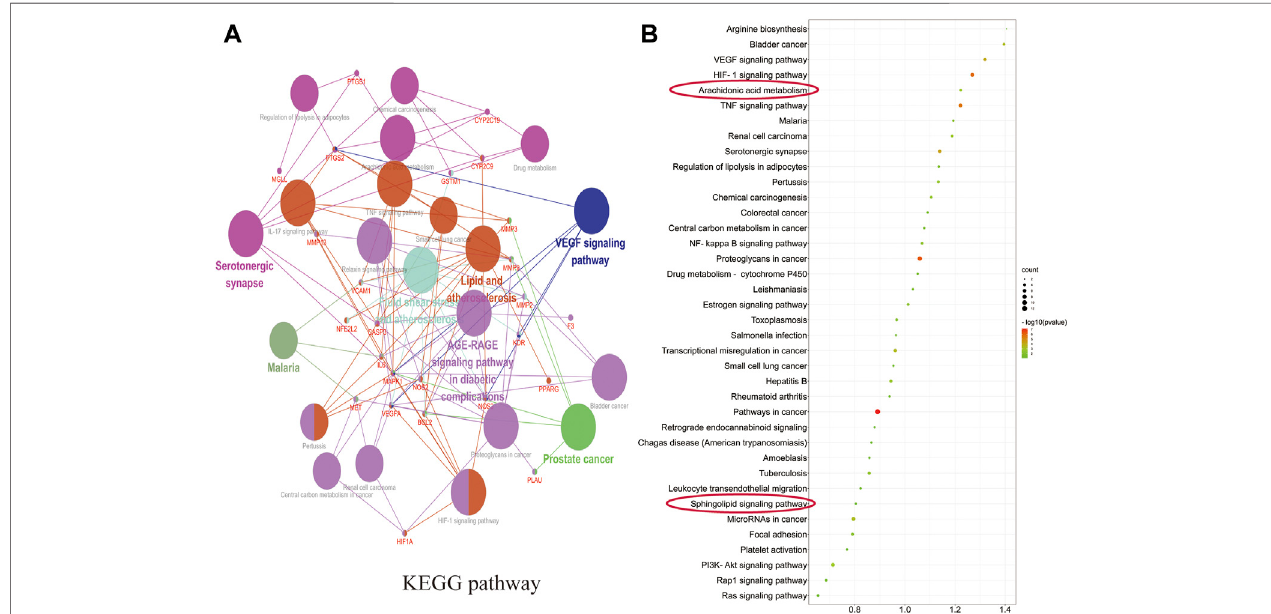
FIGURE 8 | Pathways in KEGG enrichment